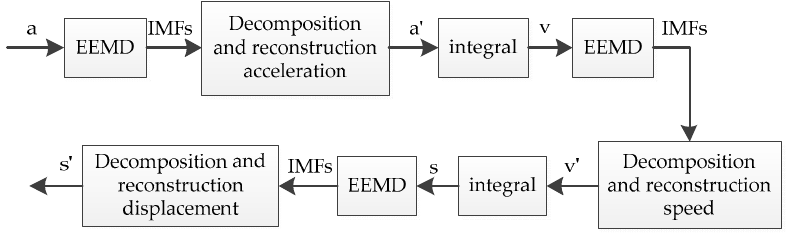
Figure 8. Flow field based on EEMD adaptive filtering process.